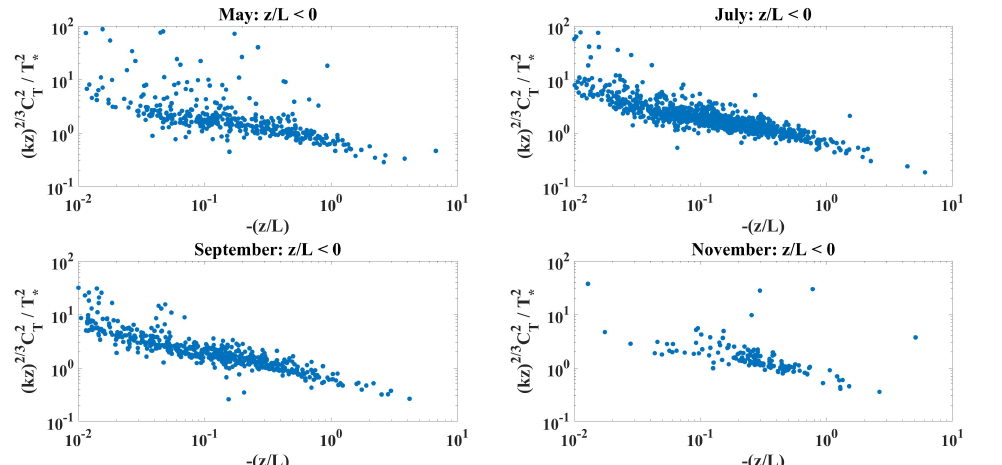
Figure 10. The Monin–Obukhov similarity function for the structure parameter of temperature, by month for z/L < 0.